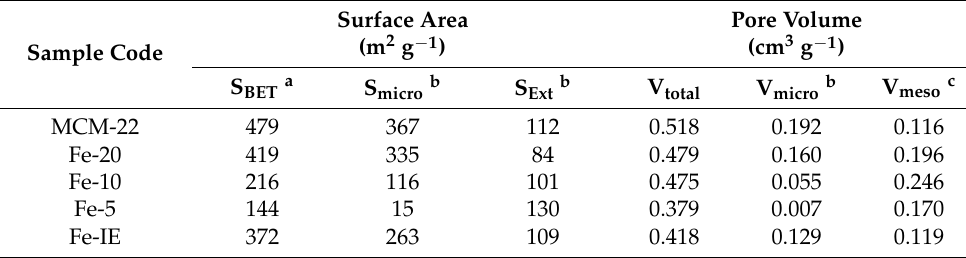
Table 3. Textural and structural properties of the